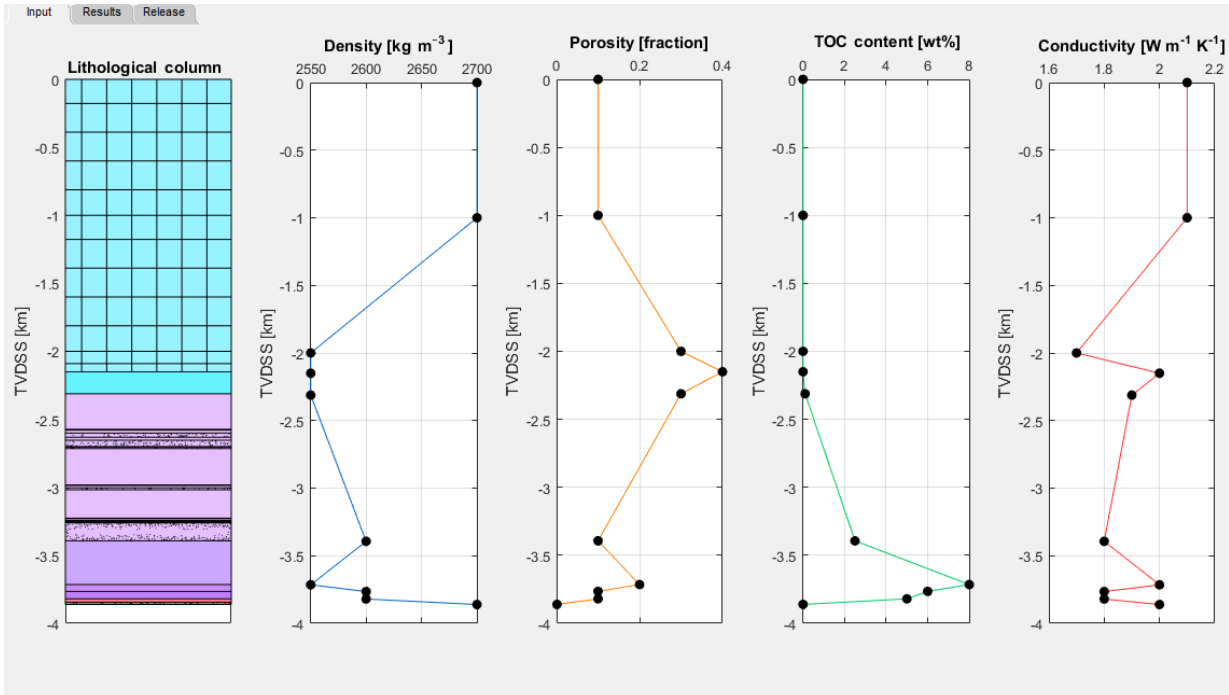
Figure 10. Input tab for